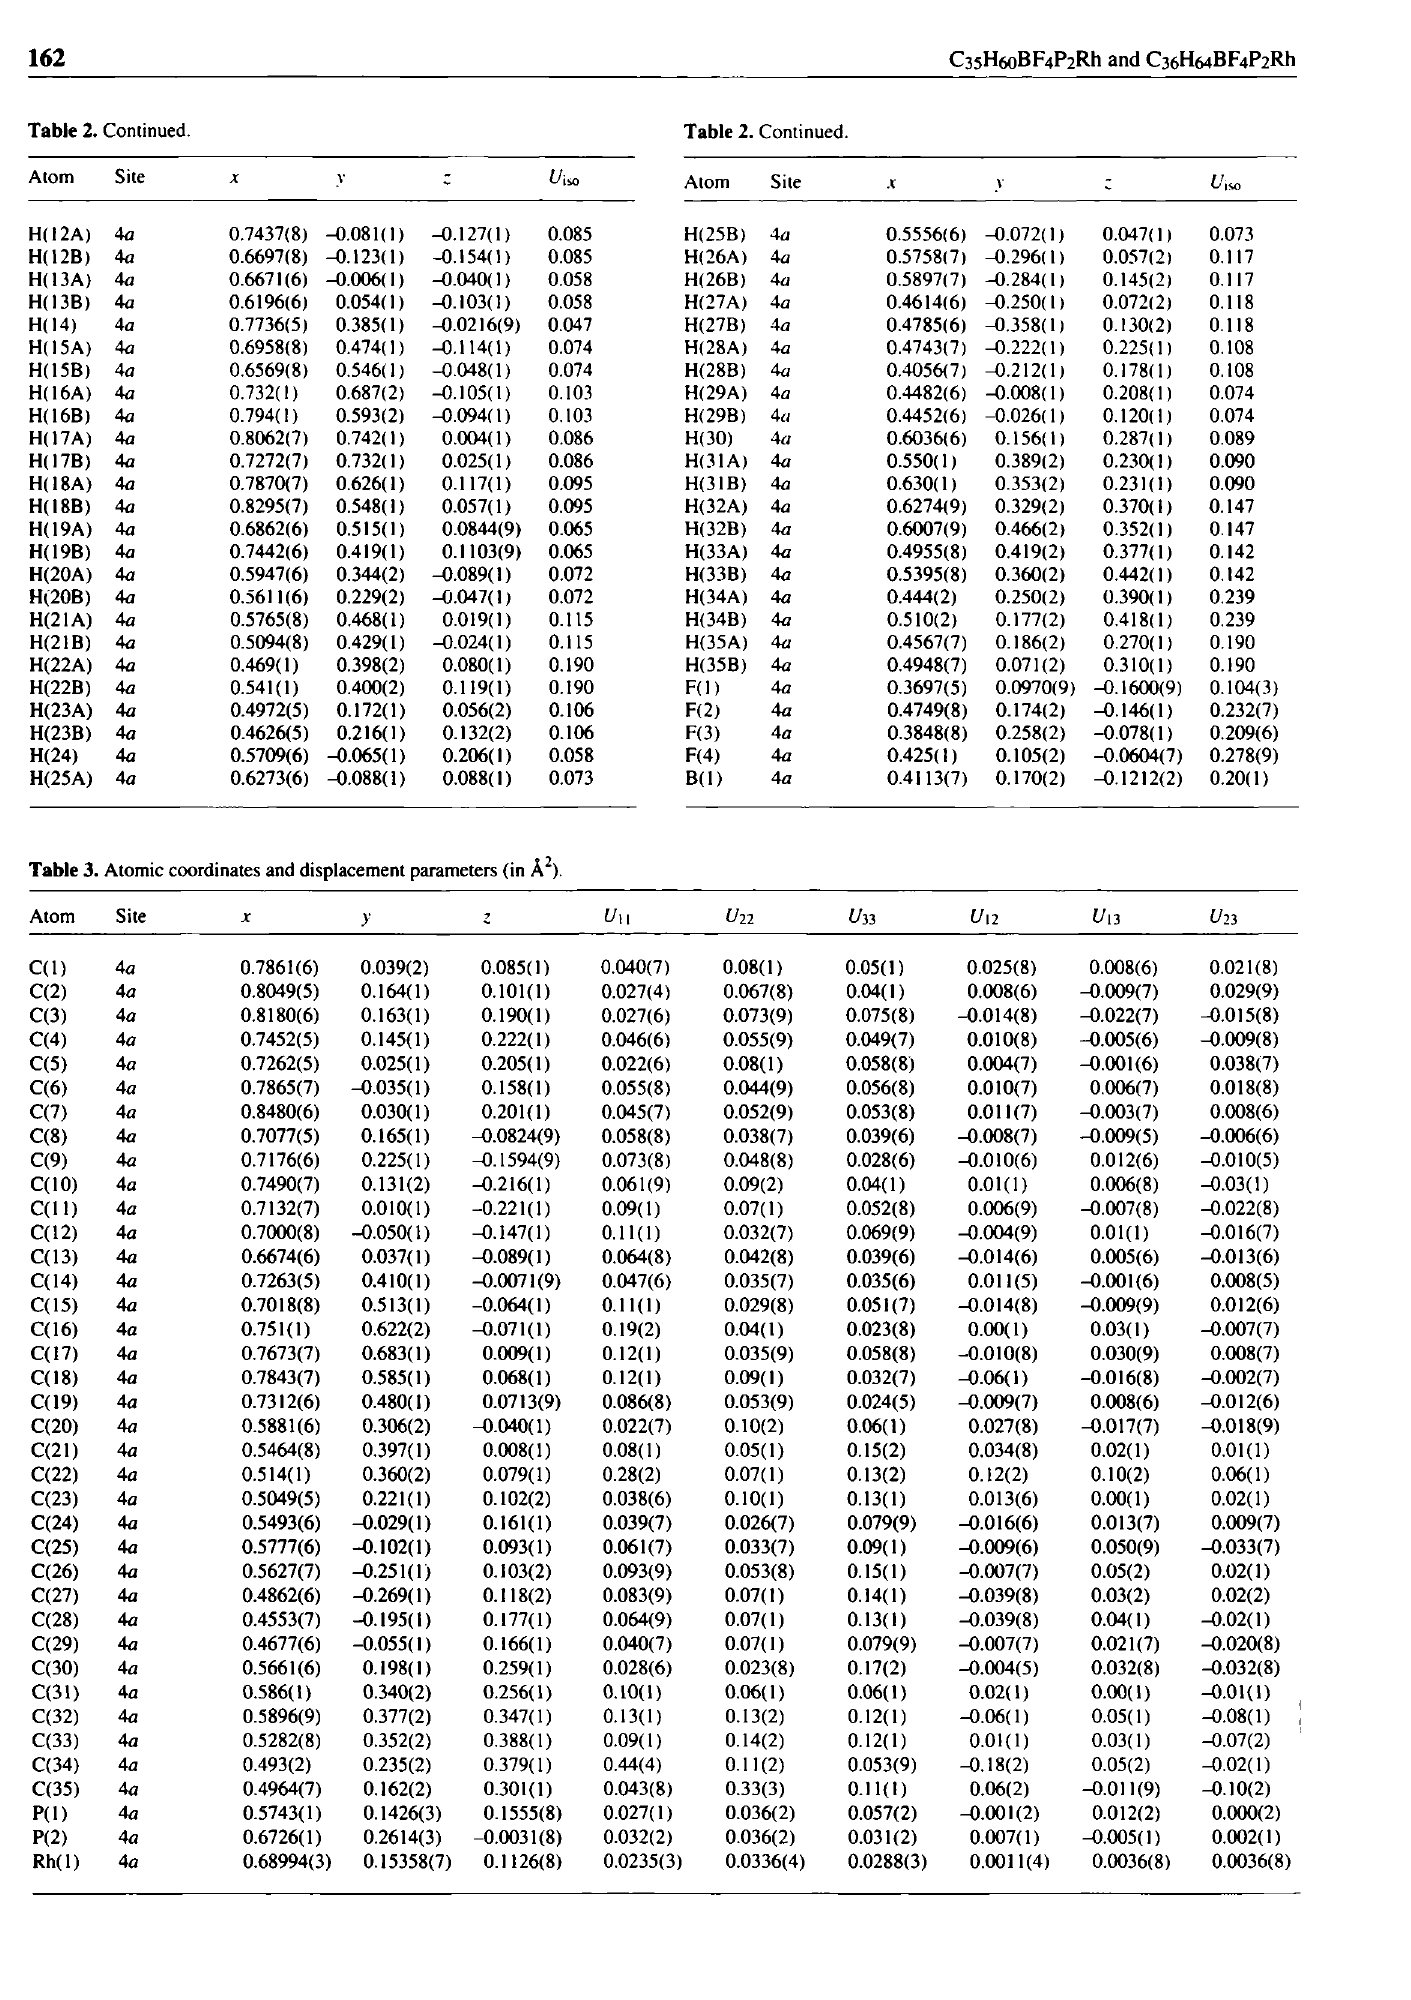
Table 3. Atomic coordinates and displacement parameters (in Ä 2